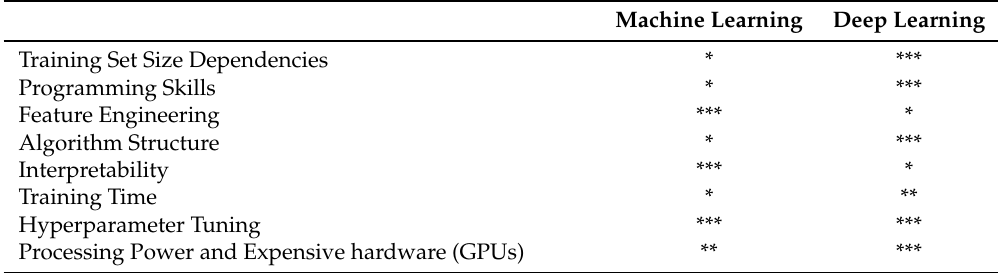
Table 5. Comparative overview table with the key differences between the two proposed frameworks in the CH domain. From low (*) to high